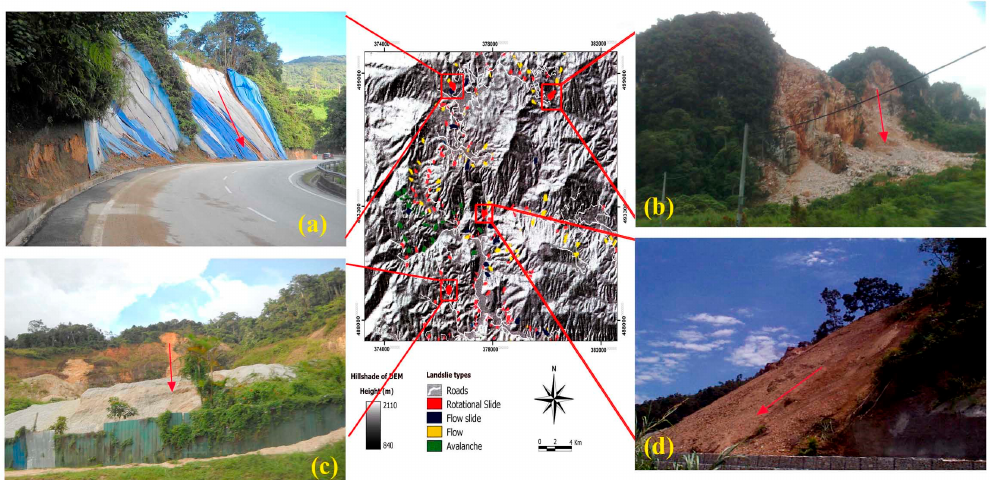
Figure 7. Final landslide inventory map: ( a ) a translation slide, ( b ) a shallow translational rockslide, ( c ) a rotational slide and ( d ) a translation slide.